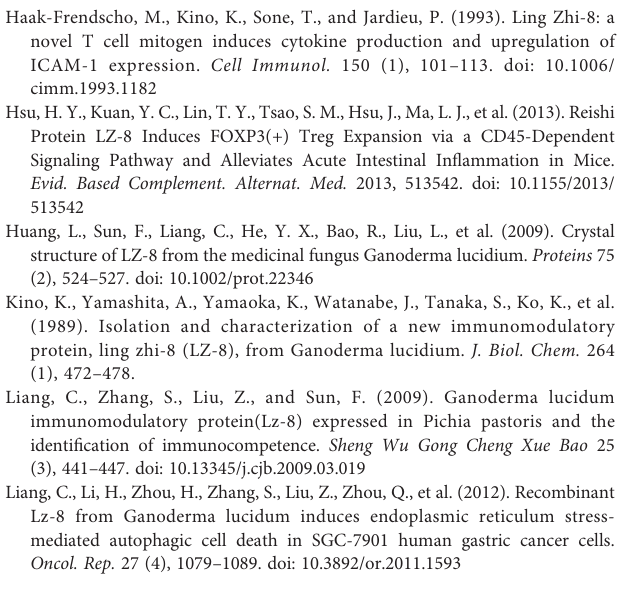
SUPPLEMENTARY FIGURE 1 | Effect of rLZ-8 on level of hormone molecules in GIOP rats serum. (A) Serum CT (ng/L); (B) Serum PTH (pg/mL); (C) Serum testosterone (ng/mL); (D) Serum estradiol (ng/L). Compared with the blank control group, * stands for P < 0.05 and ** stands for P < 0.01; Compared with the model group, △ stands for P < 0.05 and △△ stands for P <